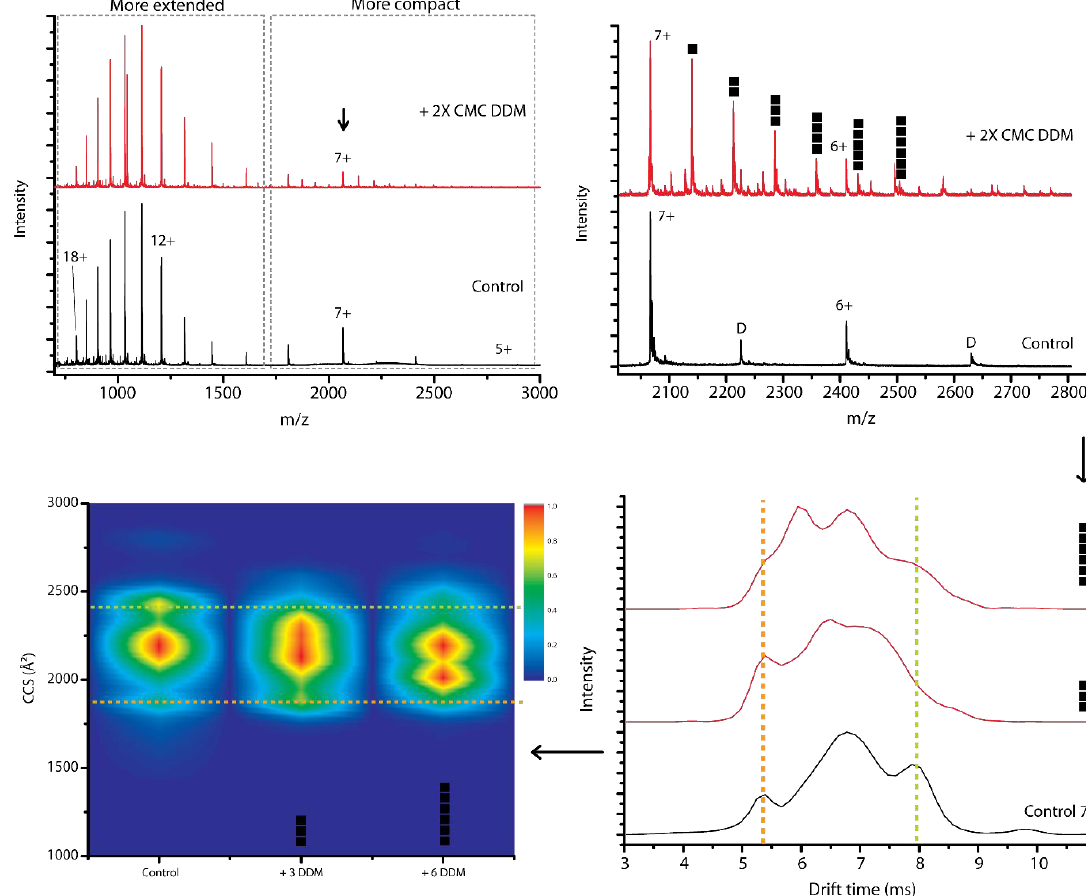
Figure 9. To obtain drift time and CCS values of unbound and detergent bound peaks, we start from the mass spectra shown in the top part of the figure for the control and the mass spectrum with DDM present. Signals that can be attributed to dimers are indicated by “D”. Specific detergent adduct peaks are selected at half height to obtain drift time information. Drift time values (bottom right) are converted to CCS values after calibration and plotted (bottom left) with normalized intensities from 1.0 (highest intensity, red) to 0.0, (not present, dark blue).